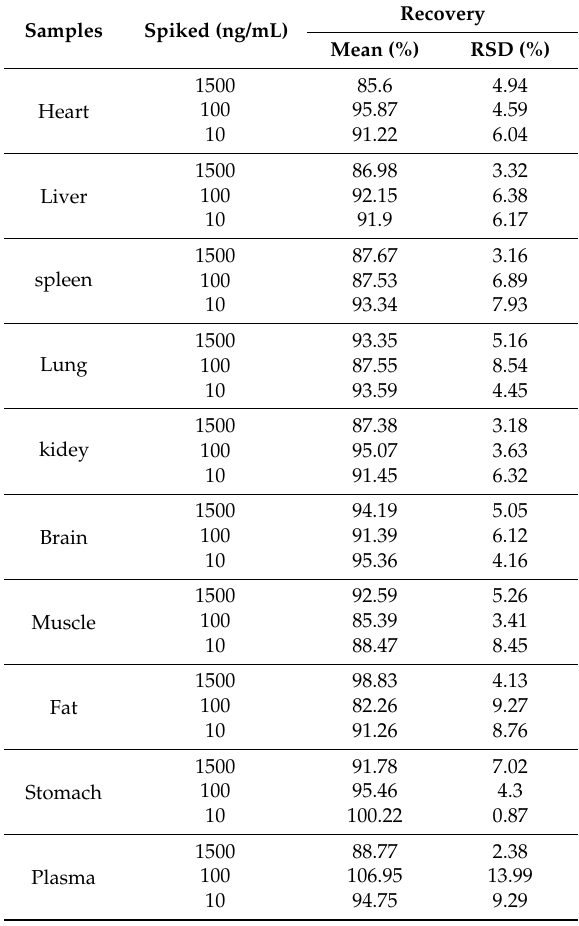
Table 4. Recovery of RUS in rat plasma and tissue homogenates (n = 6).